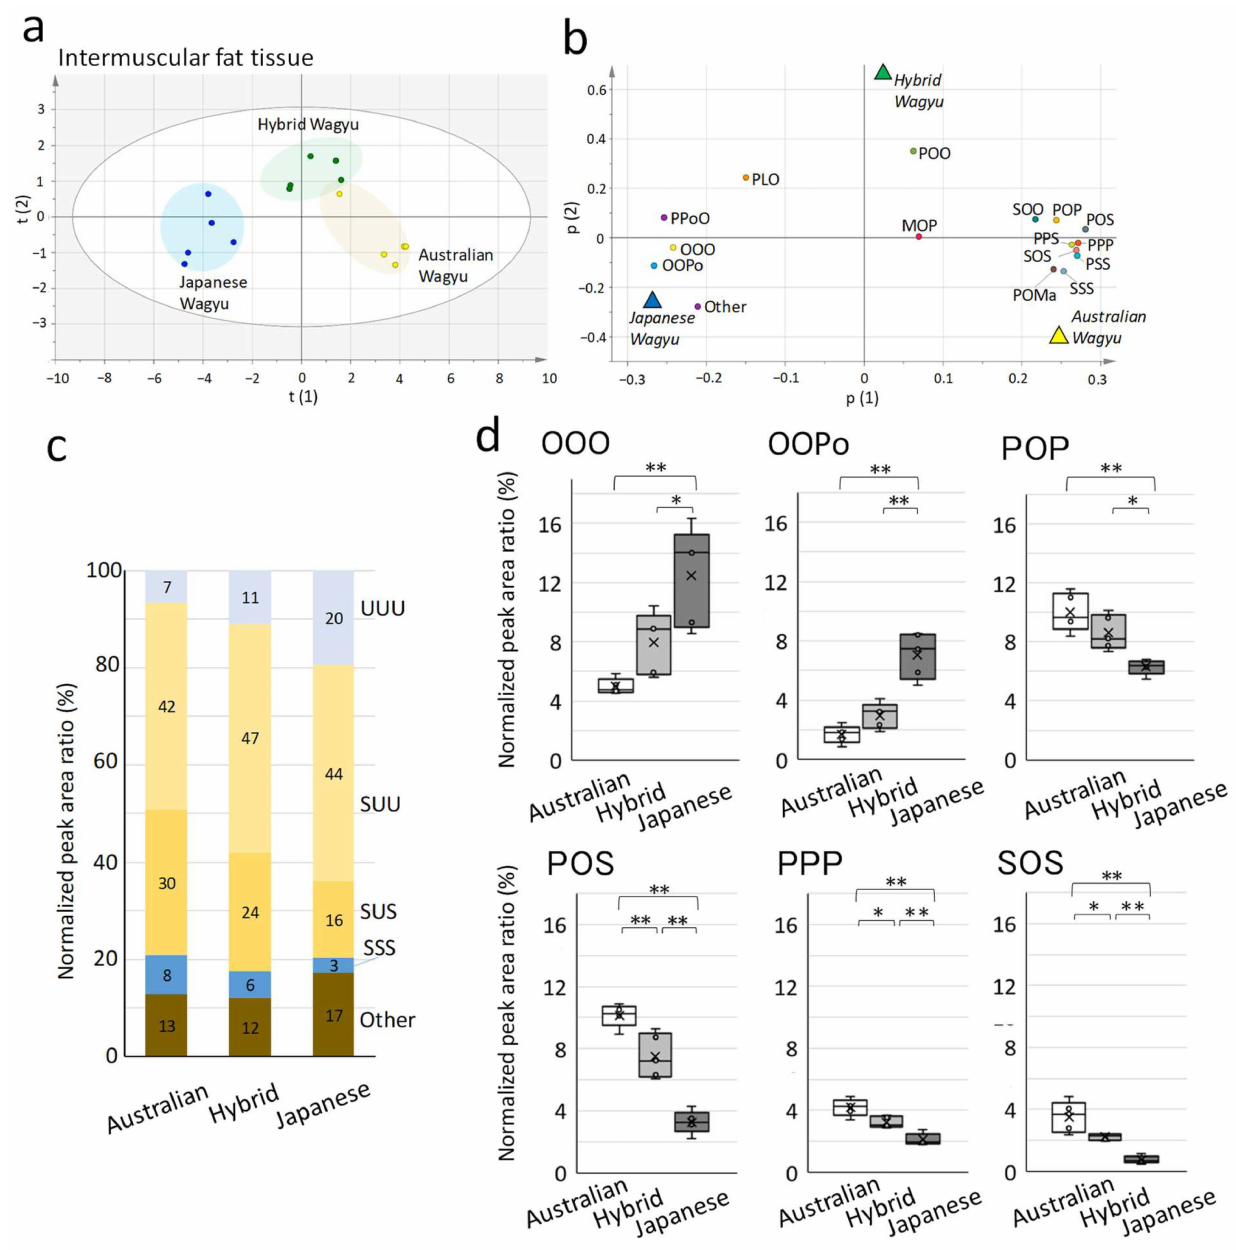
Figure 3. Comparison of triacylglycerides (TG) molecular species in intermuscular fat among Wagyu breeds. We used conventional high-performance liquid chromatography to determine the major TGs in Wagyu beef. Intermuscular fat tissues from the rib-eye area of the longissimus thoracis muscle (five Australian, five Hybrid, and five Japanese Wagyu) were used. ( a ) The score plot of orthogonal part least-square discrimination analysis (OPLS-DA) presents the relationship among the Wagyu beef types (scaling, UV). ( b ) Loading plot detailing the relationship between TG and each Wagyu breed (R2X (1) = 0.660; R2X (2) = 0.072). Italicized letters indicate the location of each DA plot (triangles) obtained by OPLS-DA. ( c ) Percentage of unsaturated fatty acids in TGs. Bar graphs present the fatty acid composition (each Wagyu, n = 5). The three-letter designations indicate the percentage of unsaturated and saturated fatty acids in the TGs. ( d ) Box plot of the exclusive median and all plots, including outliers. The cross marks indicate the mean (n = 5). Significant differences are indicated as follows: * p < 0.05 and ** p < 0.01 (Tukey’s test; Australian vs. Hybrid vs. Japanese Wagyu). Abbreviations: U, unsaturated fatty acids; S, saturated fatty